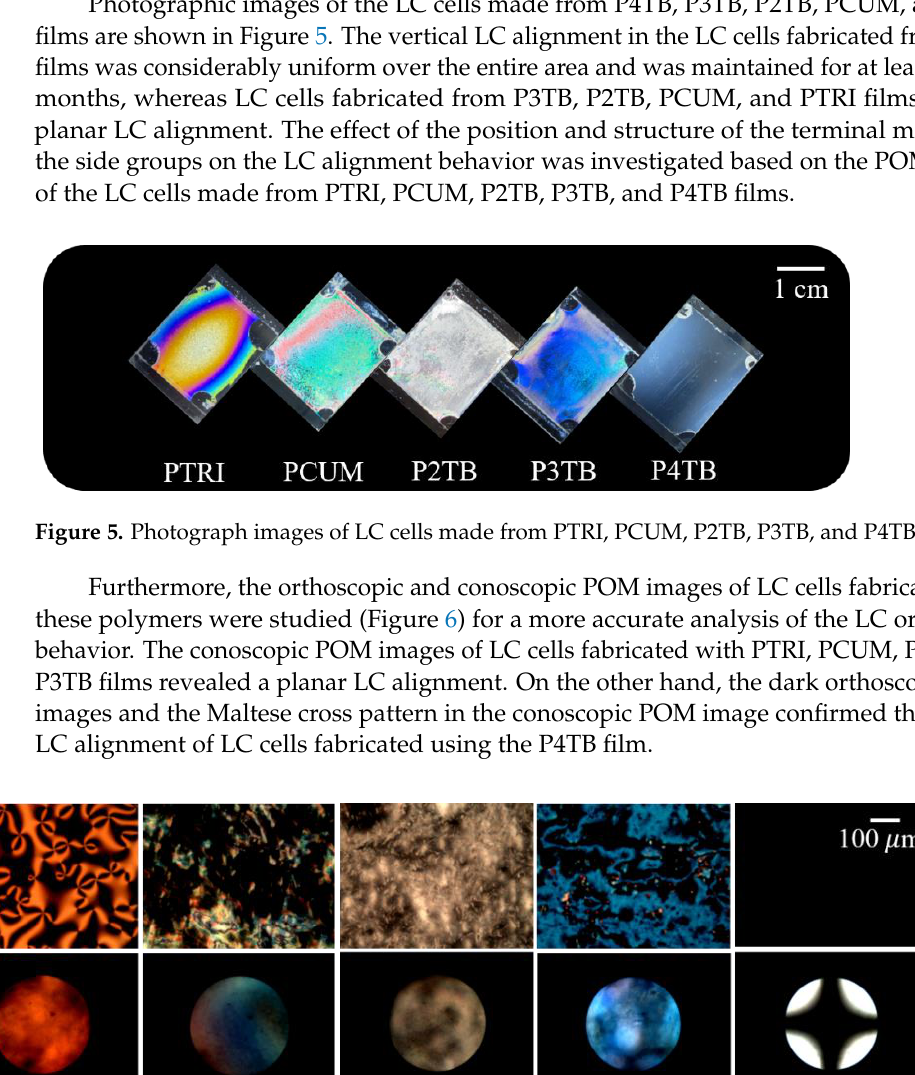
Figure 4. Conoscopic POM images of the LC cells fabricated with P4TB films under the following a weight ratio of the P4TB; ( a ) 0.001, ( b ) 0.01, ( c ) 0.05, ( d ) 0.1, and ( e ) 1.0 wt.%.